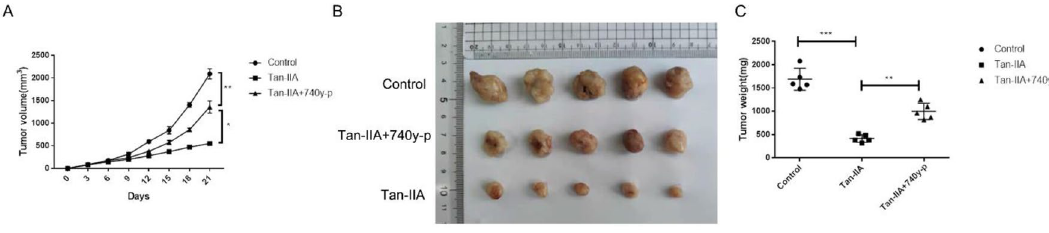
Figure 5. Tan-IIA suppresses tumor growth in vivo. Mice were treated with normal saline, Tan-IIA (50 mg/ kg) and Tan-IIA (50 mg/kg) combined with 740y-p (10 mg/kg) for 3 weeks, tumor volume was measured every 3 days (n = 5). ( A ) After treatment with normal saline, Tan-IIA and Tan-IIA combined with 740y-p for 3 weeks, tumors in these groups were removed, tumor pictures were captured ( B ) and tumors were weighed ( C ). Compared with control, * p < 0.05; ** p < 0.01; *** p <